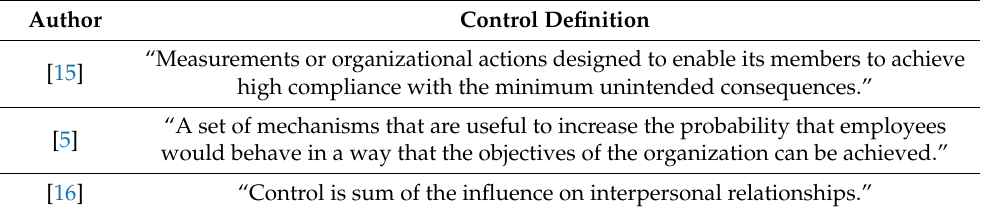
Table 1. Control